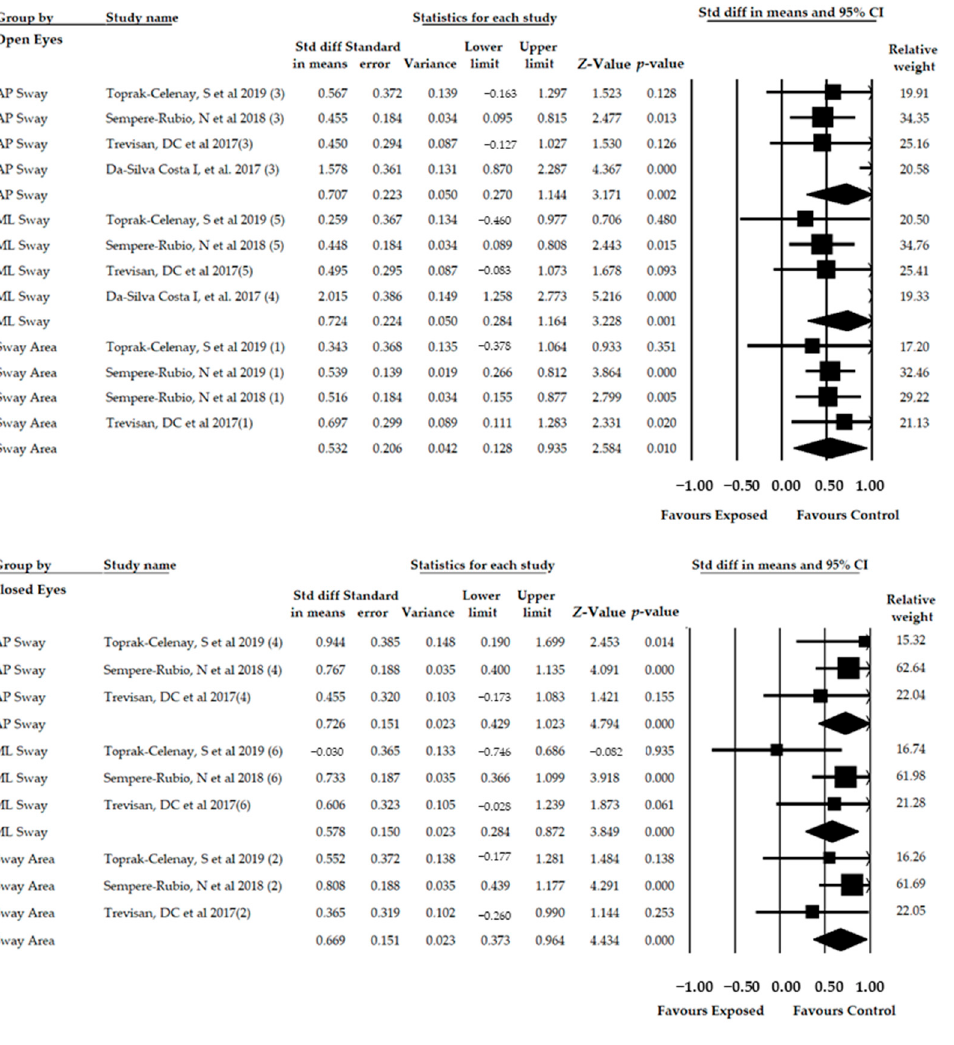
Figure 7. Forest plot of posturographical parameters of Postural Stability in Bipedal Stance. Std diff, Standardized difference; CI, Confidence